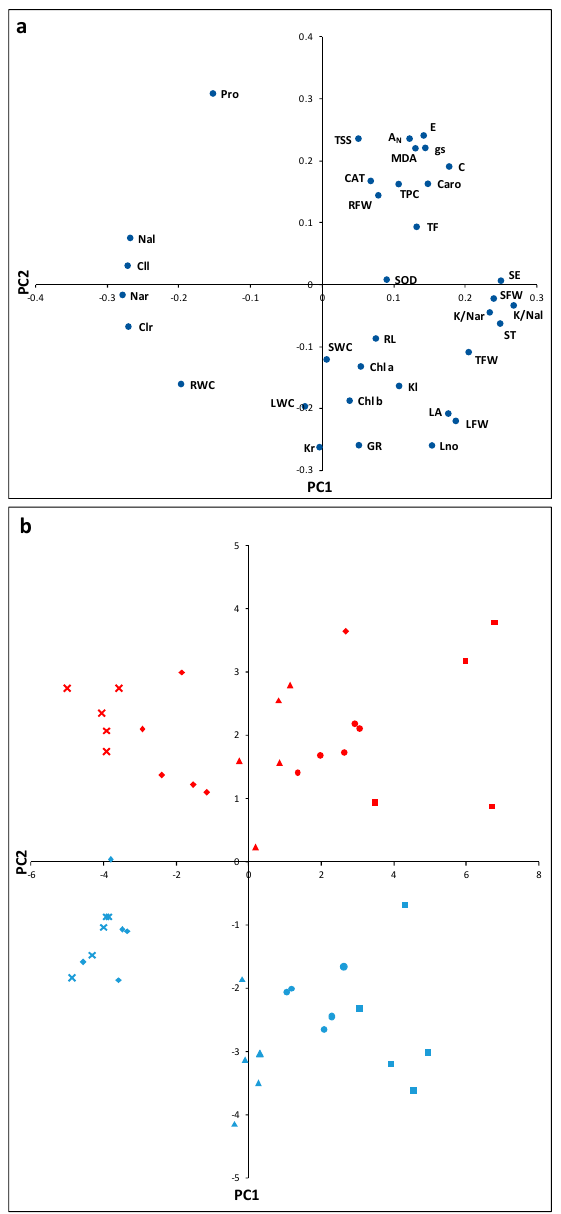
Figure 5. Loading plot ( a ) and scatterplot ( b ) of the principal component analysis (PCA) including all the analysed traits in Solanum melongena and S. incanum plants subjected for 25 days to salt treatments. The first (PC1; X-axis) and second (PC2; Y-axis) principal components accounted for 33.0% and 15.4% of the total variation, respectively. Abbreviations in the loading plot (a) are as follows: root length (RL), root fresh weight (RFW), root water content (RWC), stem elongation (SE), stem thickening (ST), stem fresh weight (SFW), stem water content (SWC), leaf number increment (Lno), maximal leaf area (LA), leaf fresh weight (LFW), leaf water content (LWC), total fresh weight (TFW), chlorophyll a (Chla), chlorophyll b (Chlb), carotenoids (Caro), photosynthetic rate (A N ), internal concentration of CO 2 (Ci), transpiration (E), stomatal conductance (gs), sodium in roots (Nar), sodium in leaves (Nal), potassium in roots (Kr), potassium in leaves (Kl), chloride in roots (Clr), chloride in leaves (Cll), ratio potassium/sodium in roots (K/Nar), ratio potassium/sodium in leaves (K/Nal), proline (Pro), total soluble sugars (TSS), malondialdehyde (MDA), total phenolic compounds (TPC), total flavonoids (TF), superoxide dismutase (SOD), catalase (CAT), and glutathione reductase (GR). Plants of S. melongena and of S. insanum are represented in blue and red, respectively, in the scatter plot (b) . Salt treatments are represented by different symbols: 0 ( ■ ), 50 (●), 100 ( ), 200 ( ), and 300 ( × ) mM NaCl.